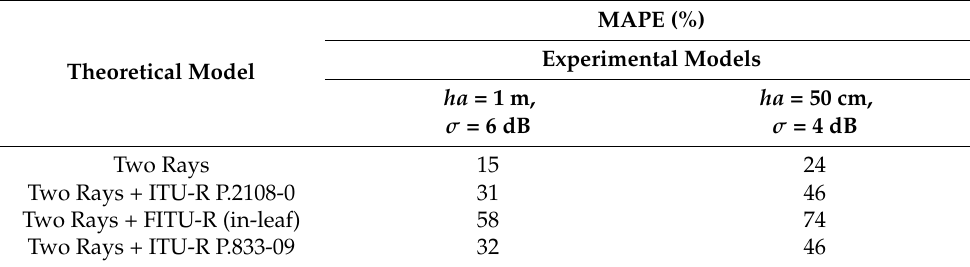
Table 10. Comparison between the theoretical two-ray model and the proposed models over water within